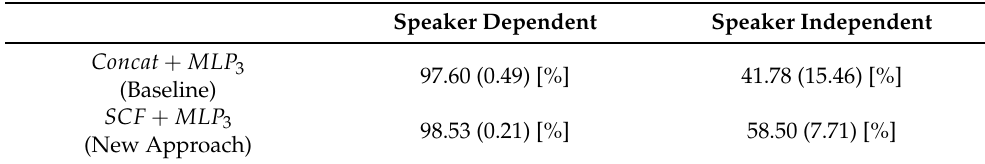
Table 4. Audiovisual results using the Columbia dataset with respect to Mean Accuracy (Standard Deviation).